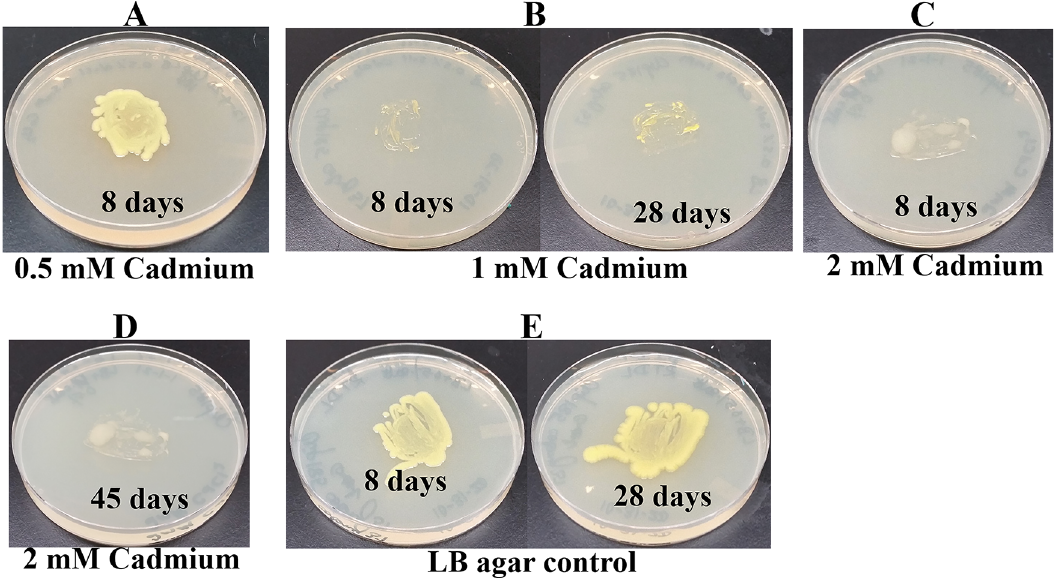
Figure 14. Growth of Clip185 on LB media containing Cadmium. (A) 8 days-growth of Clip185 on LB media containing 0.5 mM Cadmium. (B) 8 days (left) and 28 days (right)-growth of Clip185 on LB media containing 1 mM Cadmium. (C) 8 days-growth of Clip185 on LB media containing 2 mM Cadmium. (D) 45 days-growth of Clip185 on LB media containing 2 mM Cadmium. (E) 8 days (left) and 28 days (right)-growth of Clip185 on LB media (control). Number of days of growth are labeled on the figures. Light intensity was 10-15 μ mol m -2 s -1 from metal-contaminated soil in Seymour, Indiana (USA) were resistant to chloramphenicol, ampicillin and vancomy- cin. 27 In contrast, M. yannicii PS01, a multi-drug resistant strain isolated from a cystic fibrosis patient was sensitive to chloramphenicol, amoxicillin, vancomycin and colistin (polymyxin E) but resistant to Tobramycin 49 (an aminoglycoside antibiotic like neomycin, that binds to the 30S subunit of the prokaryotic ribosome).